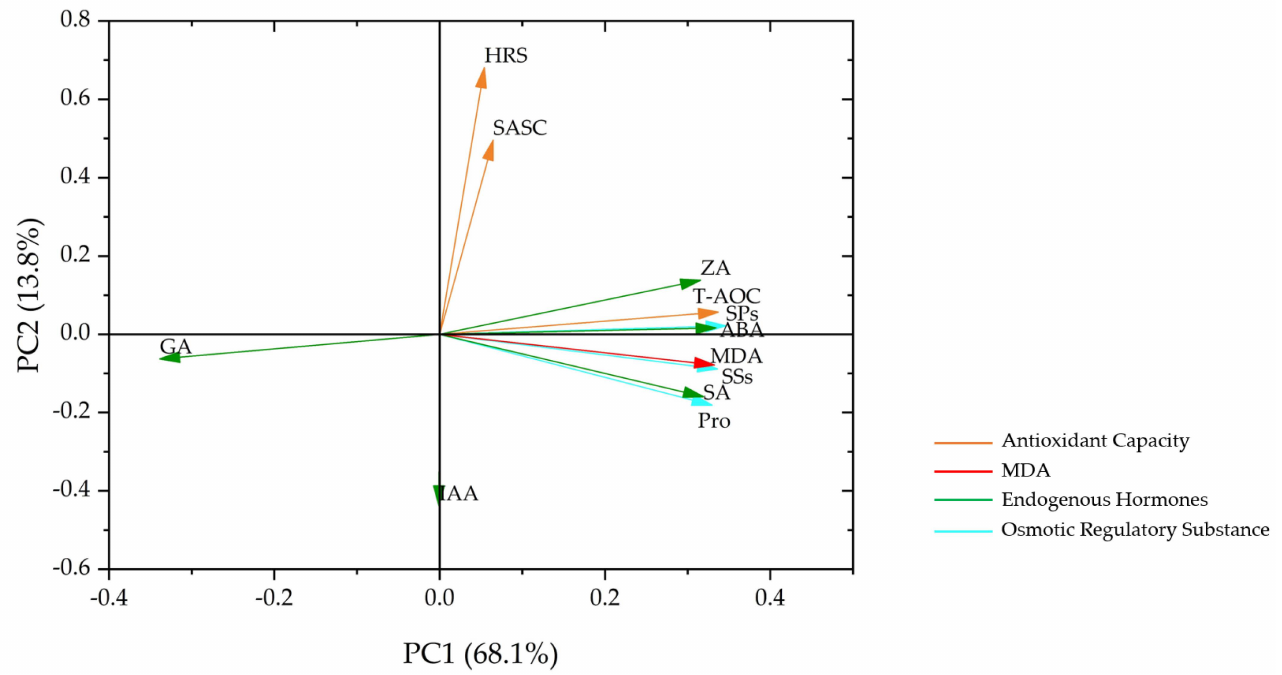
Figure 6. Principal component analysis of physiological indexes on the 5th day of drought showed that orange, red, green, and blue arrows were used to represent antioxidant capacity, MDA, endoge- nous hormones, and osmotic adjustment